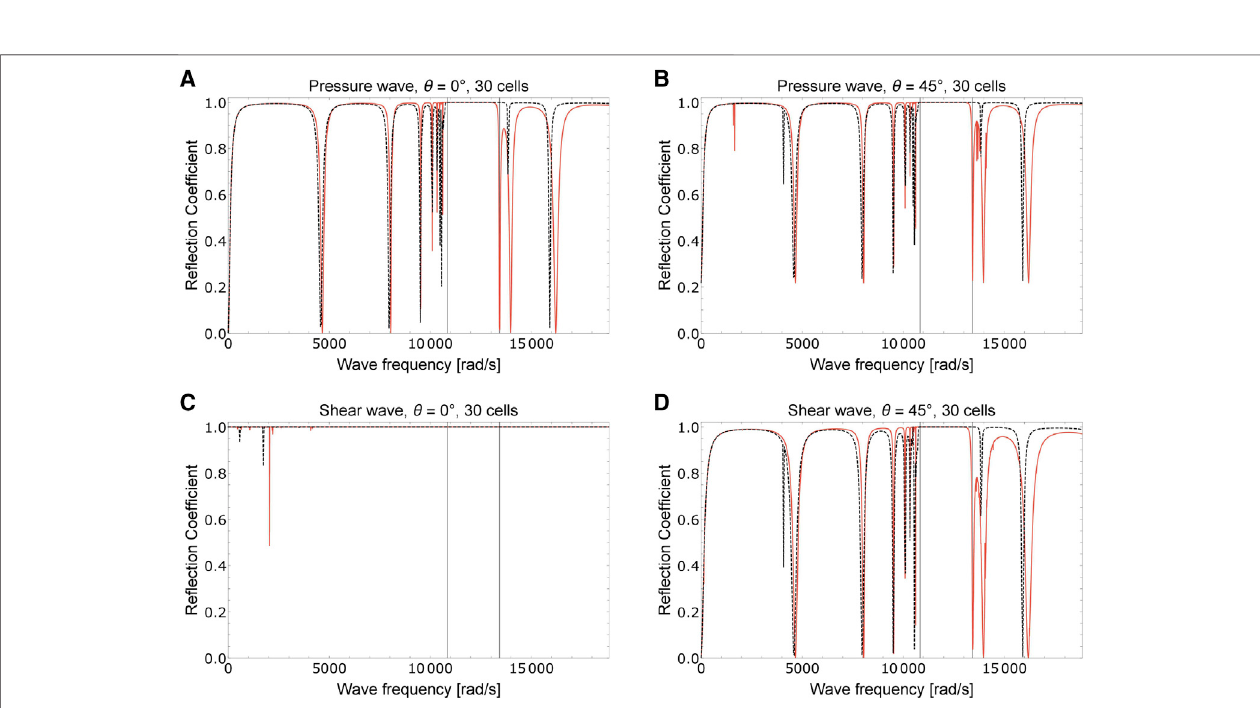
FIGURE 12 | Comparison of the microstructure ’ s (black line) and micromorphic (red line) re fl ection coef fi cient as a function of frequency for a 30 unit cells slab of MM1 andembeddedin CM3 . (A) and (E) “ pressure ” normalincidentwavewithrespecttotheslab ’ sinterfacefora25and30cellsrespectively. (B) and (F) “ pressure ” 45 ° incidentwavewithrespecttotheslab ’ sinterfacefora25and 30cells, respectively. (C) and (G) “ shear ” incidentwavenormal totheslab ’ sinterface fora25and30cells, respectively. (D) and (H) “ shear ” 45 ° incident wave with respect to the slab ’ s interface for a 25 and 30 cells, respectively.